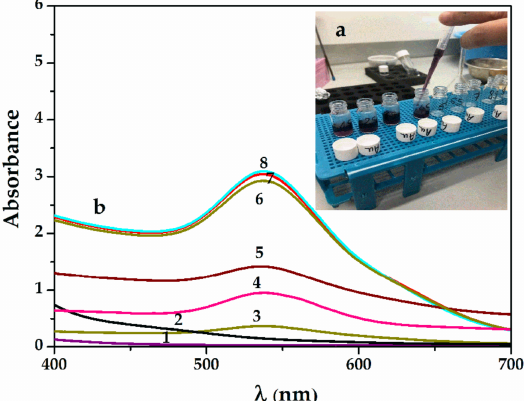
final color; ( b ) UV–Vis spectra of SauNP-WT samples obtained by reduction in time with